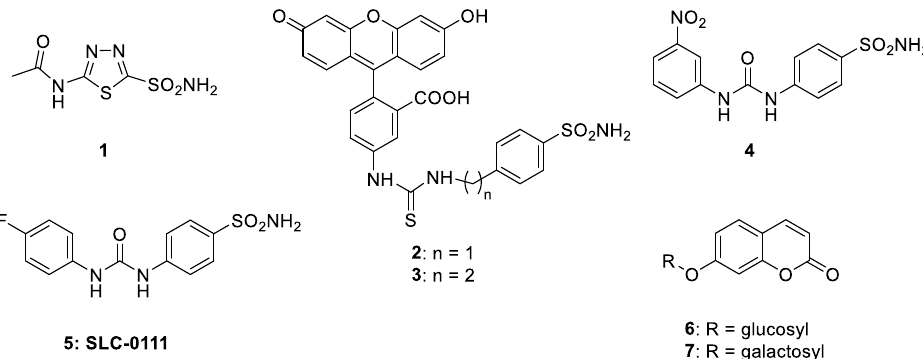
Figure 1. Carbonic anhydrase inhibitors (CAIs) that were crucial for validation of CA IX / XII as antitumor targets: acetazolamide 1 is the classical inhibitor in clinical use for decades; the fluorescein-derivatized sulfonamides 2 and 3 were used in the proof of concept studies to demonstrate the involvement of CA IX in acidification of the external pH of the tumor cell [47–50], the ureido-substituted-sulfonamides 4 and 5 were among the first CAIs to show significant antitumor effects in animal models of hypoxic tumors [51,52], together with coumarin inhibitors 6 and 7 [53].